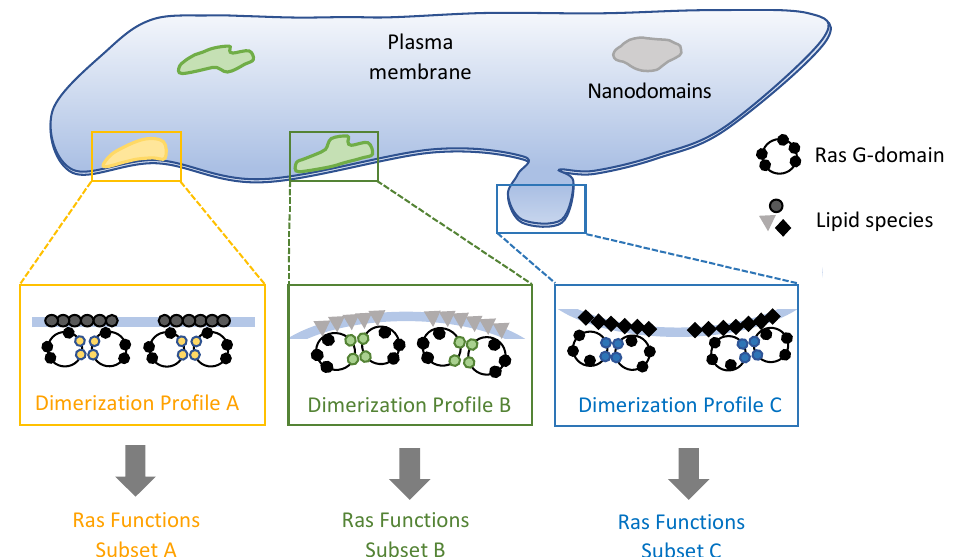
Figure 8. Model for nanodomain specific Ras dimer formation and signaling. Different Ras-associated membrane nanodomains feature unique lipid and protein compositions, physical structure, and associations with the cytoskeleton, among other properties. This leads to nanodomain-specific Ras dimerization profiles corresponding to different sets of biological functions.